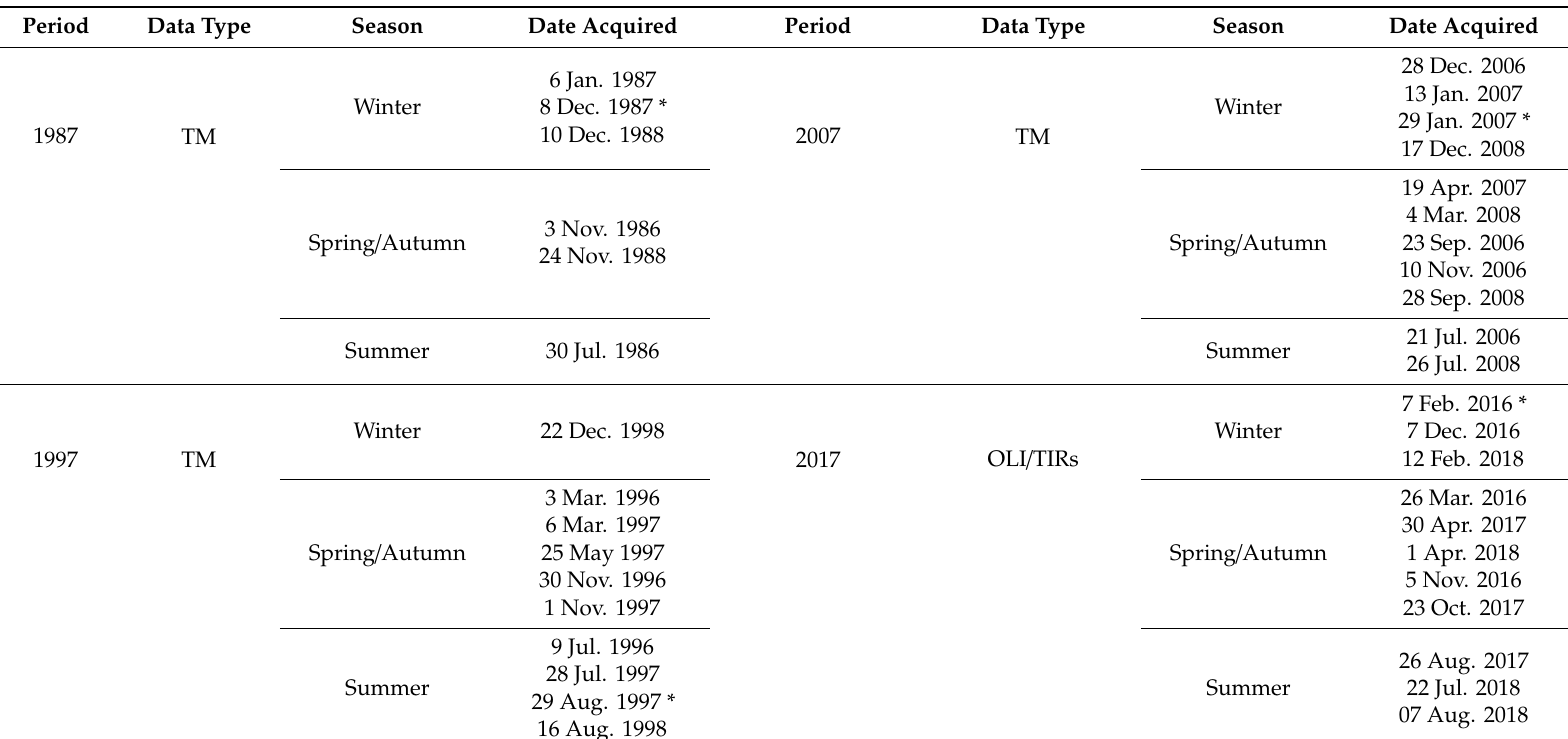
Table 1. Inventory of the Landsat TM and OLI / TIRs used in the study